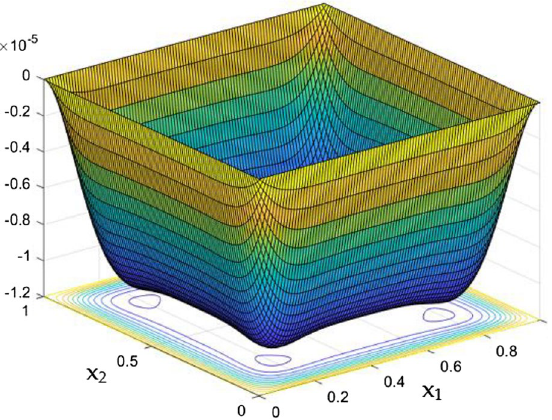
Figure 20. Temperature field for Ra = 100,000 and M = 0.